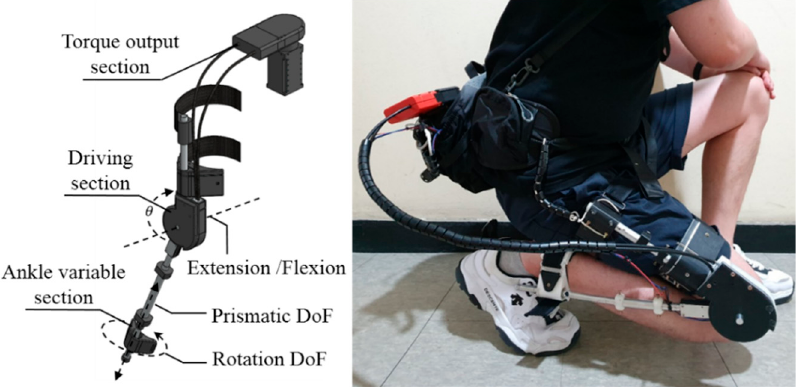
Figure 1. Full appearance of exoskeleton and actual wear appearance that shows the range of operation. The exoskeleton has three DoFs. The knee has a flexion/extension DoF, whose angle is indicated by 𝜃 . In addition, there is a passive rotation DoF and a passive prismatic DoF in the ankle. The range of motion of exoskeleton is 145 ° . The compliant structure makes it possible for the wearer to completely